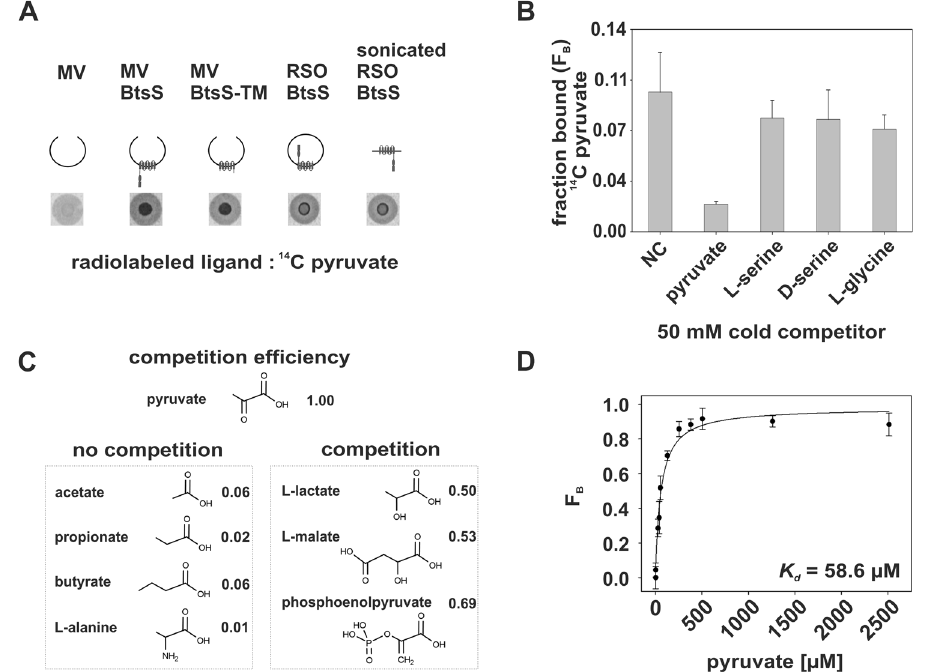
Figure 5. Analysis of the interaction of BtsS with selected ligands by DRaCALA. ( A ) A mixture of membrane vesicles (MV) or right-side-out vesicles (RSO) enriched with the corresponding proteins (indicated by graphical representations) and radiolabeled 14 C pyruvate (5 µ M) is dropped onto a nitrocellulose membrane, and ligand migration via capillary action is analyzed. ( B ) Competition assays. Binding of radiolabeled pyruvate